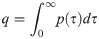
Schematic of the nested model.Bottom: the host population size Ng and the infectious cadaver population size Zg in generation g depend on host and pathogen population sizes in generation g − 1 and the disease dynamics in that generation. Following the epizootic, surviving hosts reproduce, and virus-killed cadavers overwinter to start the epizootic in the following year. Middle: the disease dynamics in generation g − 1 follow a stochastic SEIR model [35], such that a susceptible host Si becomes exposed Ej to infectious cadaver Pk at rate viq, where vi is the risk of exposure for host i and q is the probability of death given exposure, which arises from the within-host virus dynamics. Note that the "Removed" class R, corresponding to inactivated cadavers, is not explicitly shown. The probability of a host dying from virus infection at time τ post exposure, p(τ), is determined by the dynamics of the pathogen within a host. q is related to p(τ) in that q=∫0∞p(τ)dτ. Top: within a host, virus particles x can reproduce or interact with immune cells y, resulting in the removal of both the virus particle and the immune cell. An infection fails to kill the host if all virus particles are cleared so that x = 0, but the host dies if the total number of virus particles reaches an upper threshold C. Further details are in Section C of S1 Text. To produce a model that lacks replicative drift, we assume that fl(τ), the frequency of a virus strain l at time of death τ, is equal to the frequency of that strain immediately after the time of exposure fl(0). To produce a model that lacks transmission bottlenecks, we assume that the number of copies of a virus strain l at the beginning of an infection xl(0) is equal to the total number of virus particles that invade the host ∑lxl(0) multiplied by the relative frequency of that virus strain in the cadaver that caused exposure Pl / (∑pPp). In the purifying selection model, host death occurs only if a larva was susceptible to one or more of the virus strains in the cadaver to which it was exposed. If so, the virus strains that the host was susceptible to are released upon host death at frequencies equal to those in the infecting cadaver. SEIR, Susceptible-Exposed-Infectious-Removed.